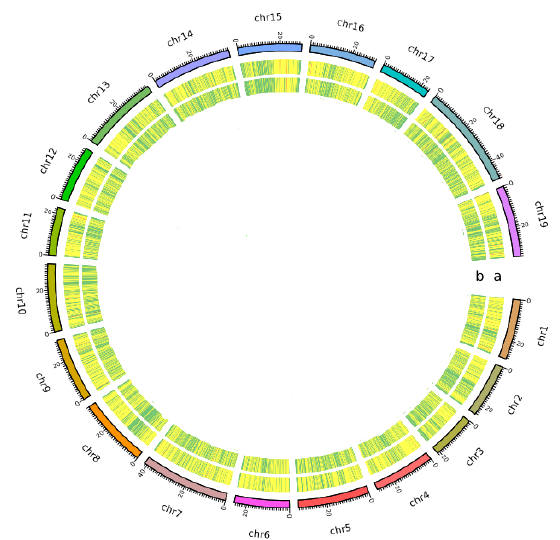
Figure 1. Overall view of the motif distribution of SSRs and SNP density in the genome of nineteen ‘PN40024’ chromosomes (chr1–chr19) was assembled by Hi-C. ( a ) SSR; ( b ) SNP.